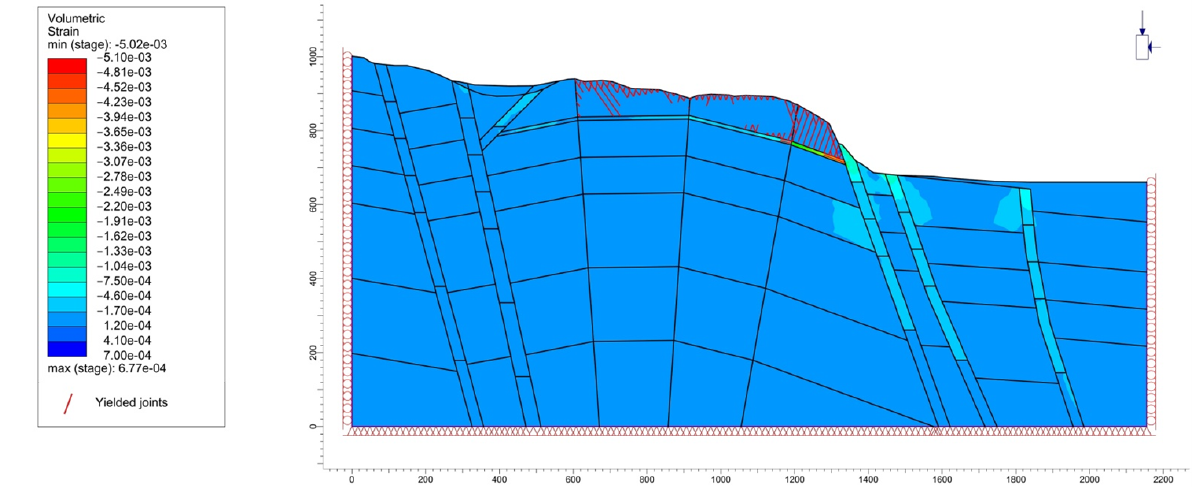
Figure 11. Volumetric strain and yielded joints in the present condition, after all unloading stages and creep evolution. x -axis is in meters, while y -axis is in meters